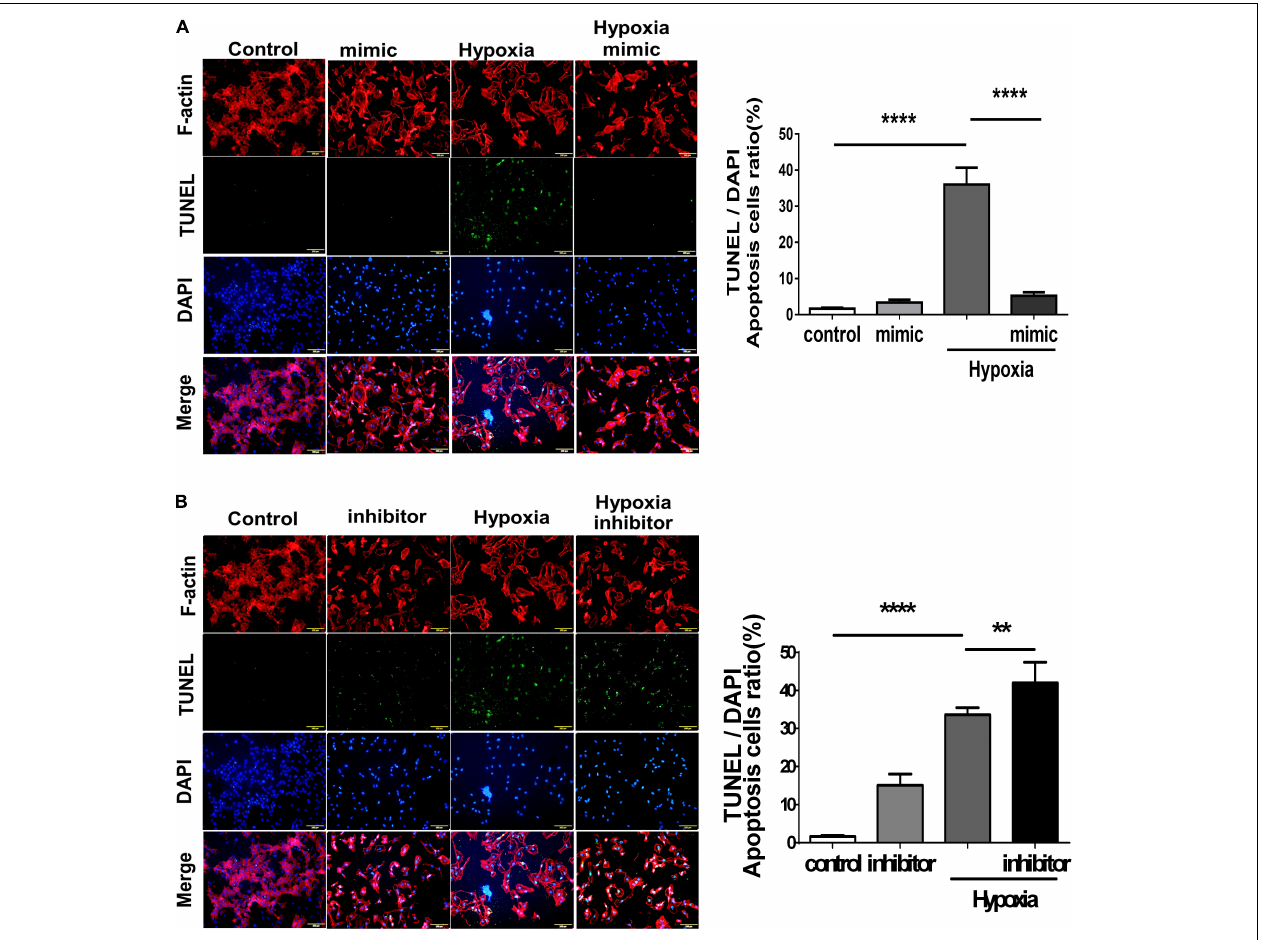
FIGURE 4 | Overexpression of miR-21 mitigates hypoxia-induced cell apoptosis in human umbilical vein endothelial cells (HUVECs). TUNEL staining in HUVECs pretreated with (A) miR-21 mimic or (B) miR-21 inhibitor under hypoxia stimulation for 24 h. The experiment was conducted in triplicate, ** P < 0.01 and **** P <